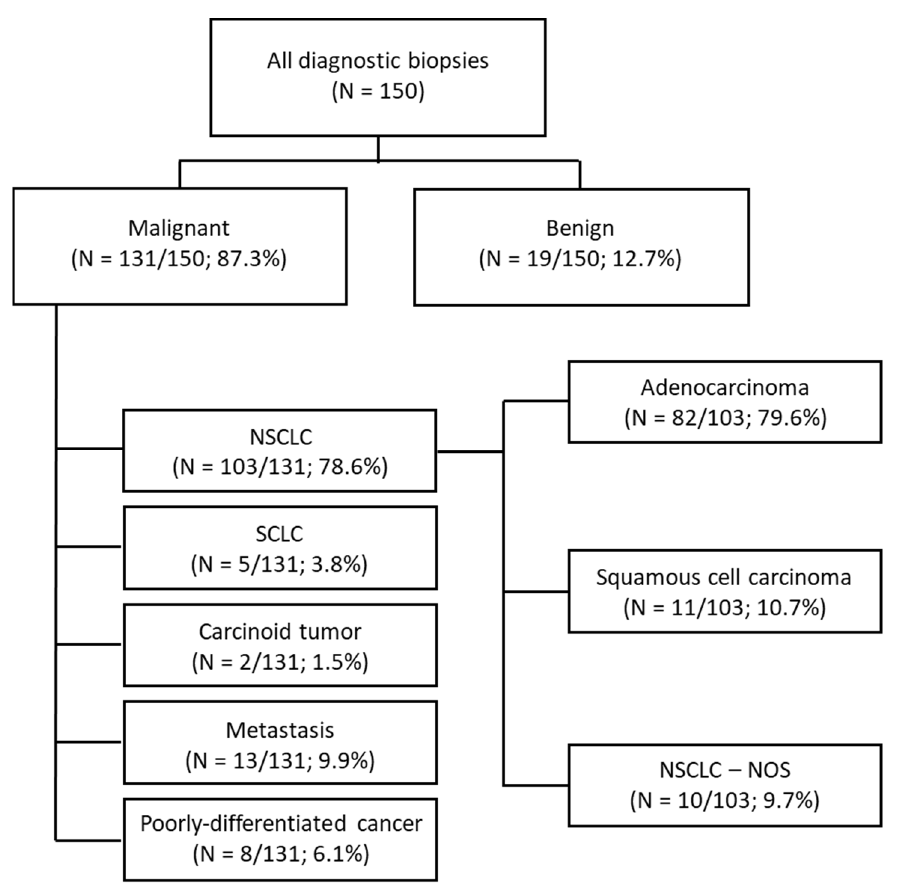
Figure 2. Flow diagram showing the distribution of diagnostic biopsy results of malignancy.